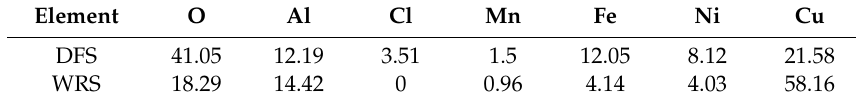
Table 4. The composition of DFS and WRS immersed in 3.5% NaCl solution for 3 h (atom.%).